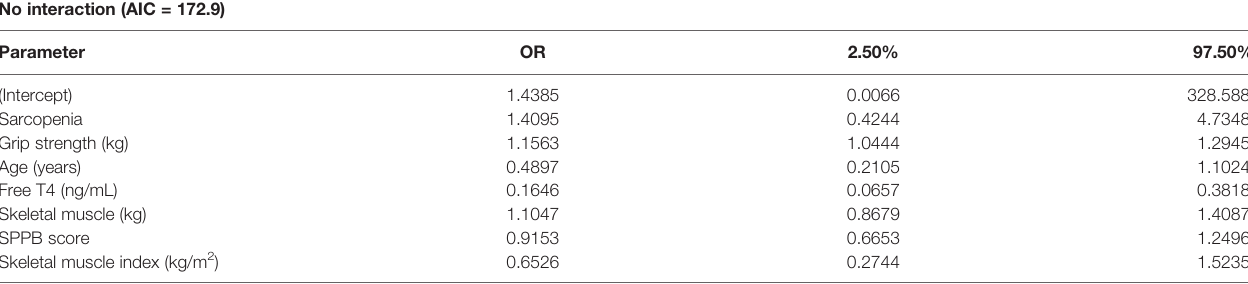
SPPB, short physical performance